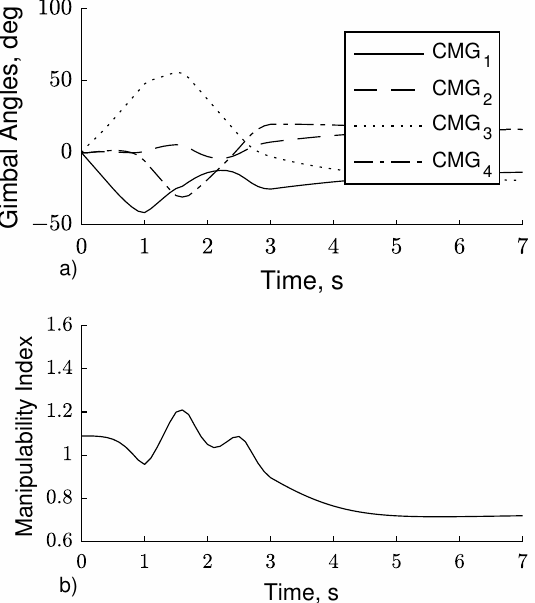
Figure 9. Simulation results with DNN. ( a ) Gimbal angles, ( b ) Manipulability